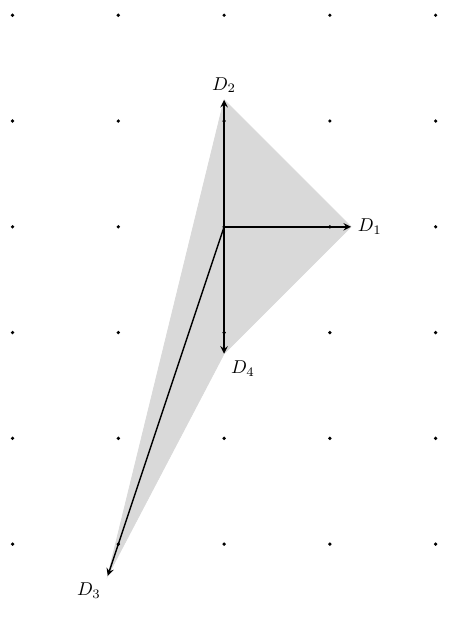
Figure 1 . Toric fan for F